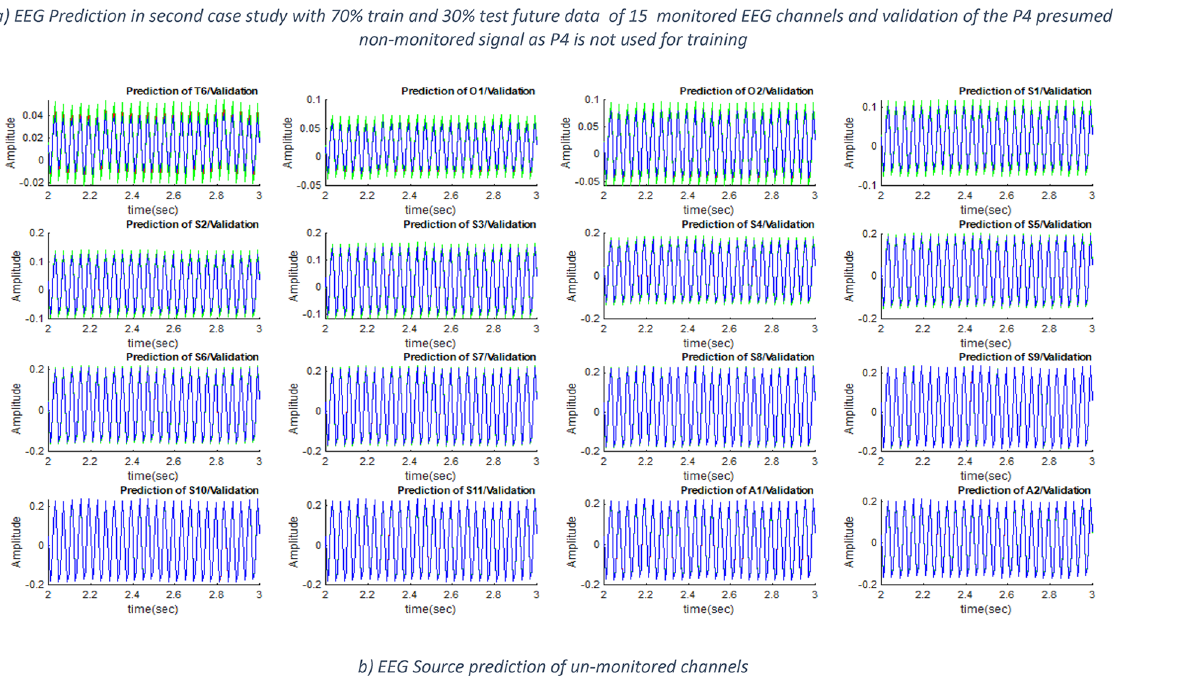
Figure 6. Predicted signals of second case study experiment at 32 locations (15 EEG channels and 17 other locations) (a) EEG Prediction of monitored 15 channels + the non- monitored P4 channel signal prediction along with the filtered input EEG data; (b) EEG source prediction of un-monitored 16 channels by MRI-cSNNr model (the red line) versus the real EEG signal after it is filtered (the blue line) and the spike-based MRI-sSNNr model (the green line). MRI-cSNNr indicates higher precision prediction in comparison to